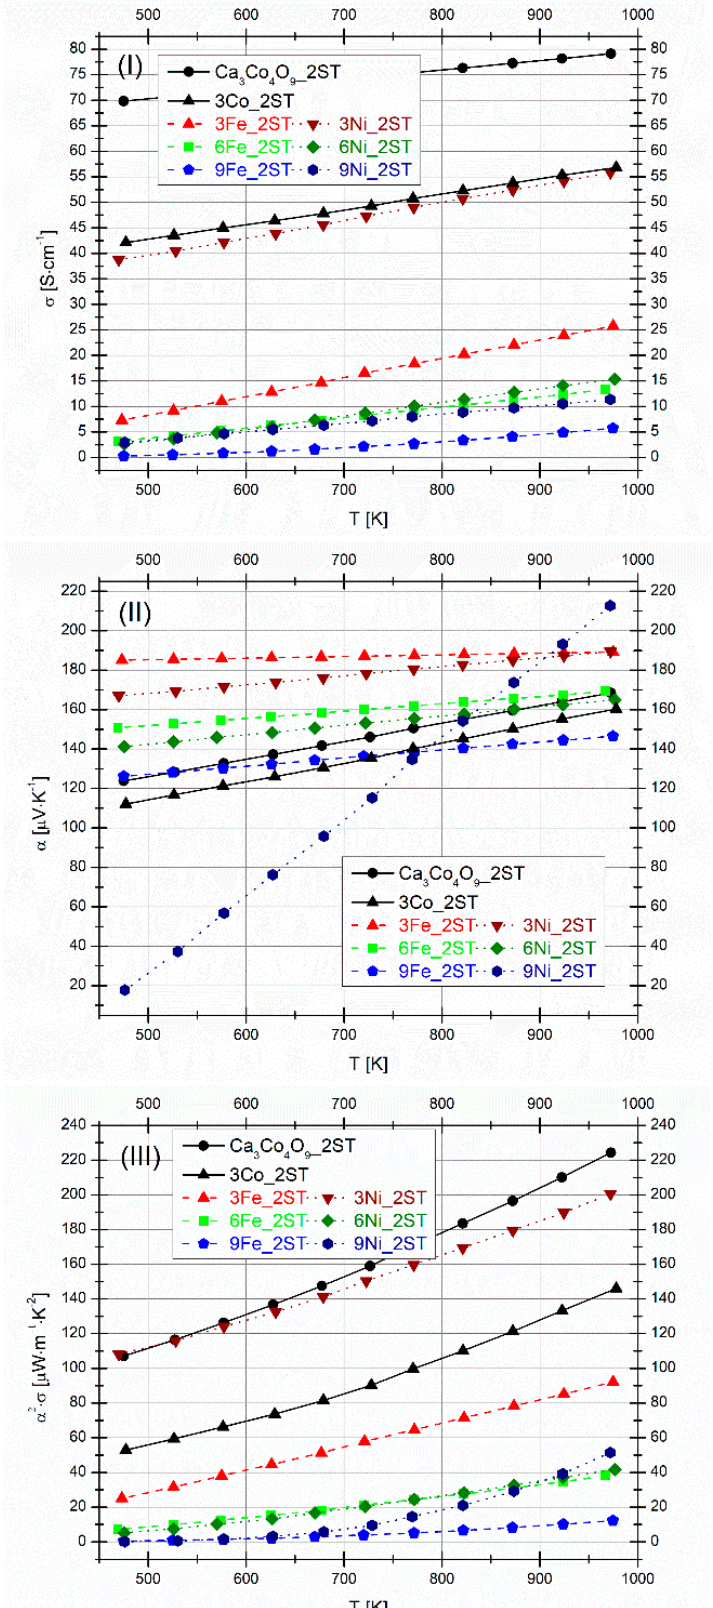
Figure 9. Electrical conductivity ( I ), Seebeck coefficient ( II ) and power factor ( III ) for 2ST sintered samples. The results for selected Co additions are presented for comparison.